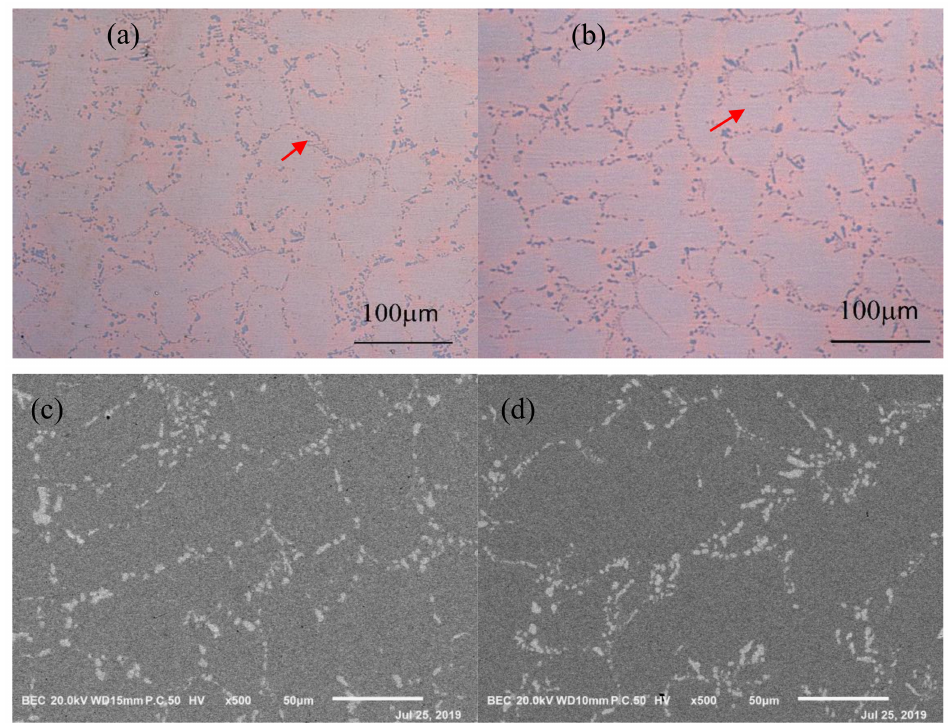
Figure 2. Metallographic of ( a ) as-cast and ( b ) annealed Cu–Zr bulk alloys without corrosion and field emission scanning electron microscope (FE-SEM) images of ( c ) as-cast and ( d ) 360 ◦ C annealed Cu–Zr bulk